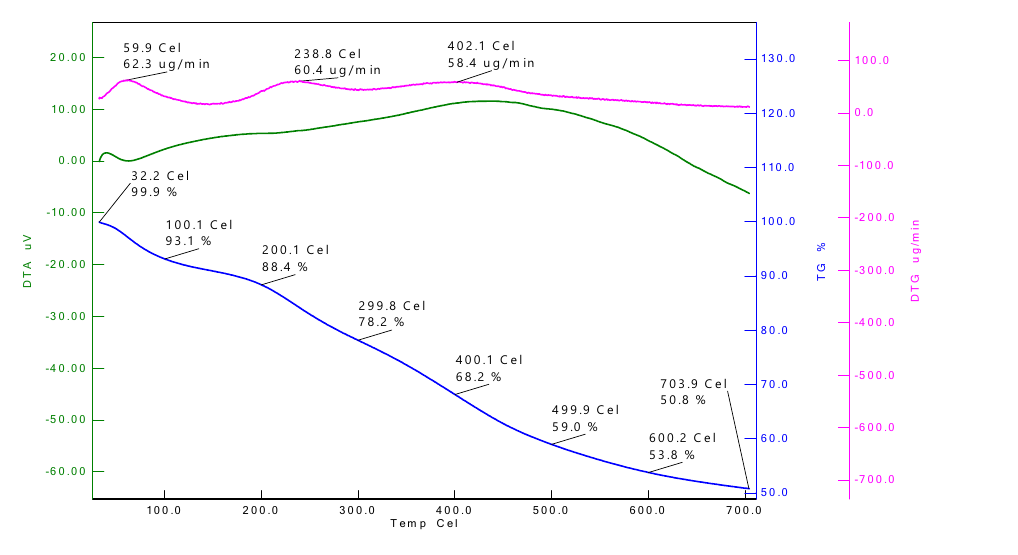
Figure 8. TGA/DTA curve of SANH18